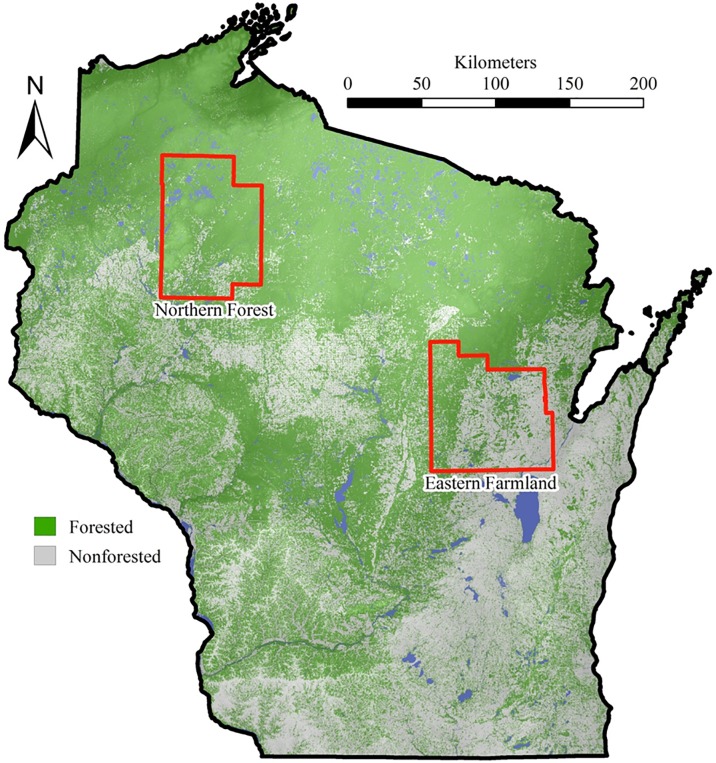
White-tailed deer (Odocoileus virginianus) sites of capture throughout northern and eastcentral Wisconsin, USA, 2010–2013.The thick black line delineates the state boundaries and thick red lines delineate study area (e.g., northern forest, eastern farmland) boundaries (Created by A. Norton using ArcMap 9.2. Forestland: Wisconsin Department of Natural resources 1998 WISCLAND land cover, Madison WI. County Outlines: U.S. Census Bureau. 1999 Wisconsin County Outlines, Madison, WI).